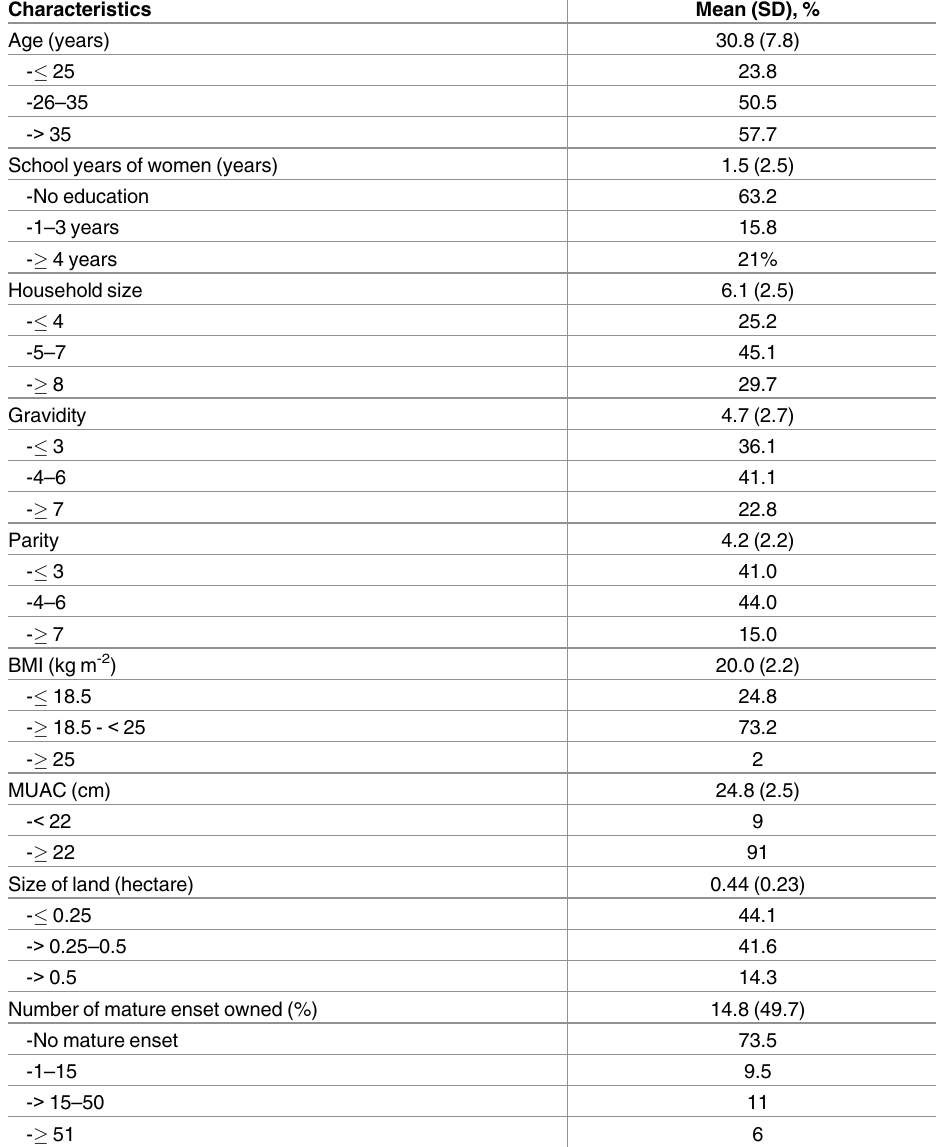
Table 1. Anthropometric, demographic and socioeconomic characteristics of women from Sidama zone, southern Ethiopia (n = 202).